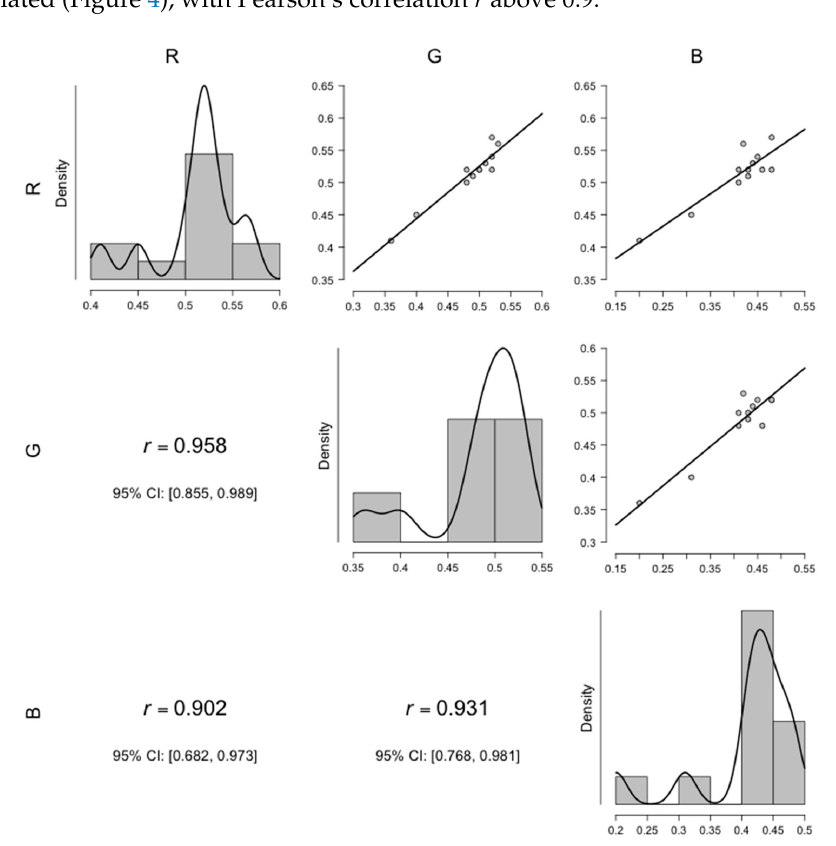
R = red; G = green; B = blue; ANCOVA = analysis of covariance; SE = standard error; df = degrees of freedom; t = student’s t statistics.